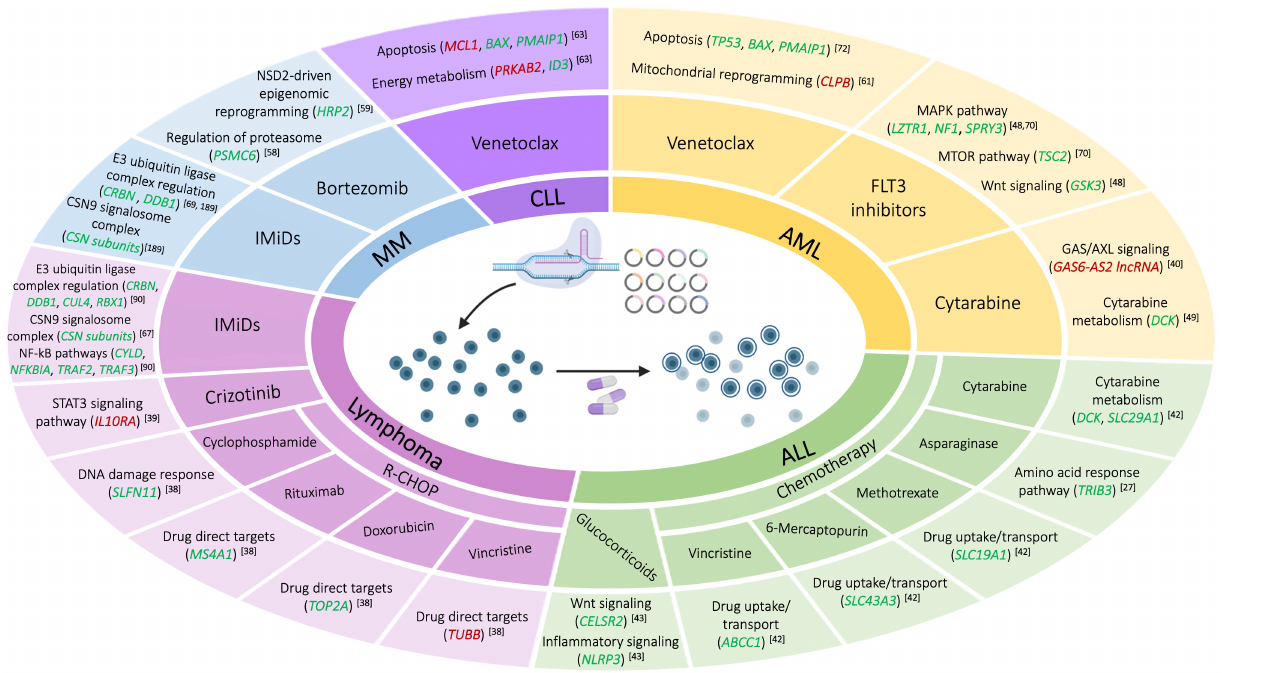
Figure 1. Drug resistance mechanisms identified by CRISPR screening in the main hematological malignancies, reviewed in this work. Diseases are in the inner circle (AML, acute myeloid leukemia; CLL, chronic lymphoblastic leukemia; MM, multiple myeloma; ALL, acute lymphoblastic leukemia); therapies are in the middle circle (IMIDS, immunomodulatory drugs; R-CHOP, rituximab, cyclophos- phamide, doxorubicin, vincristine, and prednisone); main pathways, in which each set of validated genes is involved, are in the outer ring. In green, the loss of the gene produces the gain of resistance; in red, the overexpression of the gene produces drug